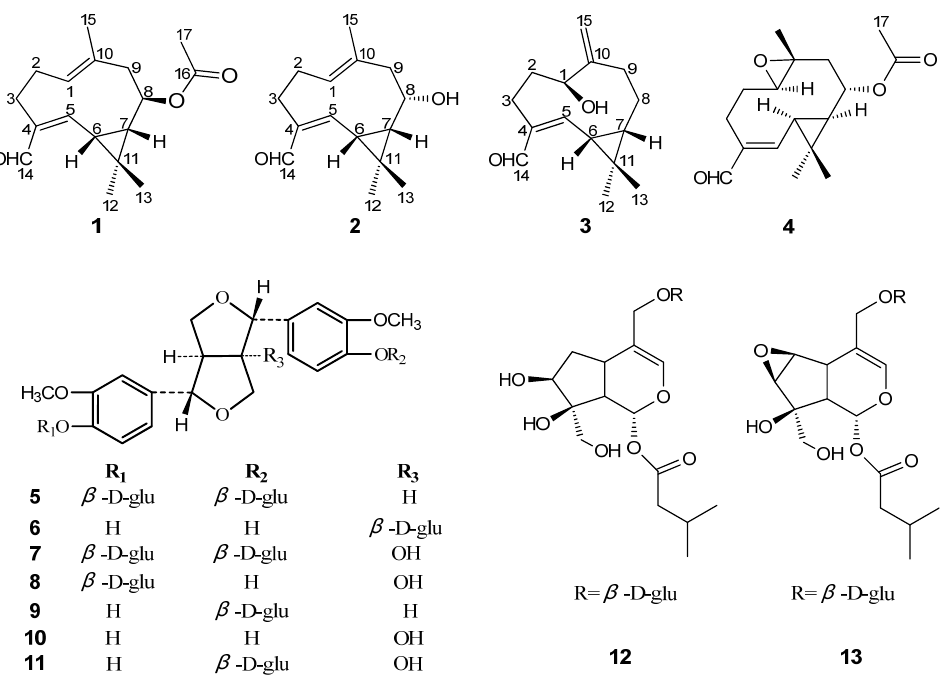
Figure 3. Structures of compounds 1 – 13